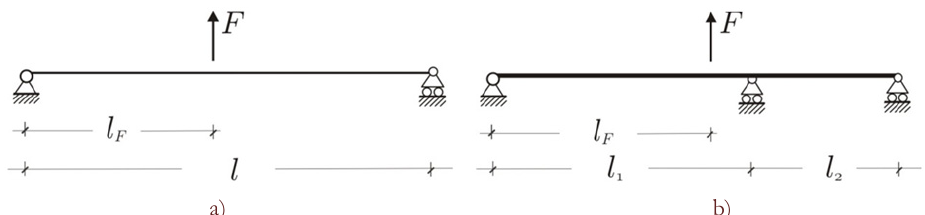
Figure 1: Systems under investigation. a) Simple supported beam, l =0.6 m, l F =0.26 m (quasi symmetric) or l F =0.04 m (asymmetric). b) Spanned beam, l 1 =0.4 m, l 2 =0.2 m, l F =0.3 m or l F =0.5